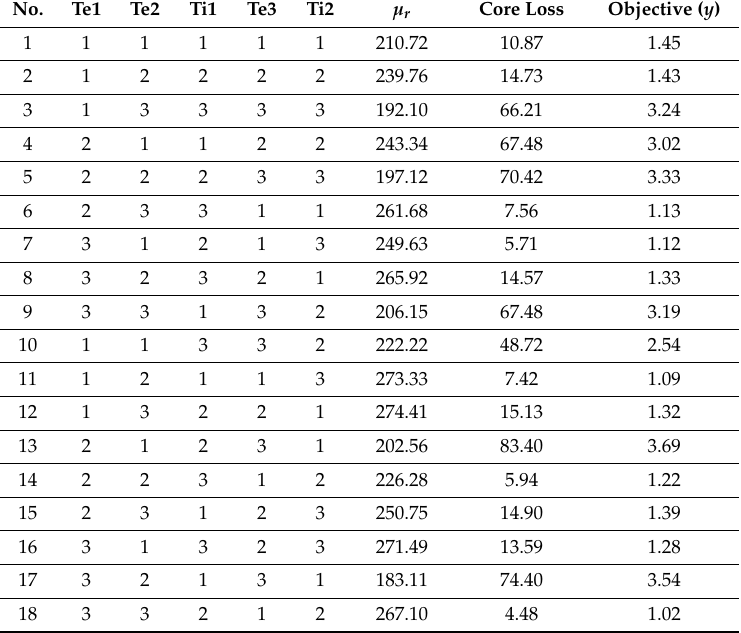
Figure 5b–d show the measured magnetization curves (with hysteresis loops) for the first three samples listed in Table 3. Meanwhile, a clamp meter (type: Fluke 345) is used to measure the input power. Based on the experimental results, the values of relative permeability ( µ r ) and core loss (unit: W/kg) of these 18 samples can be estimated, as listed in Table